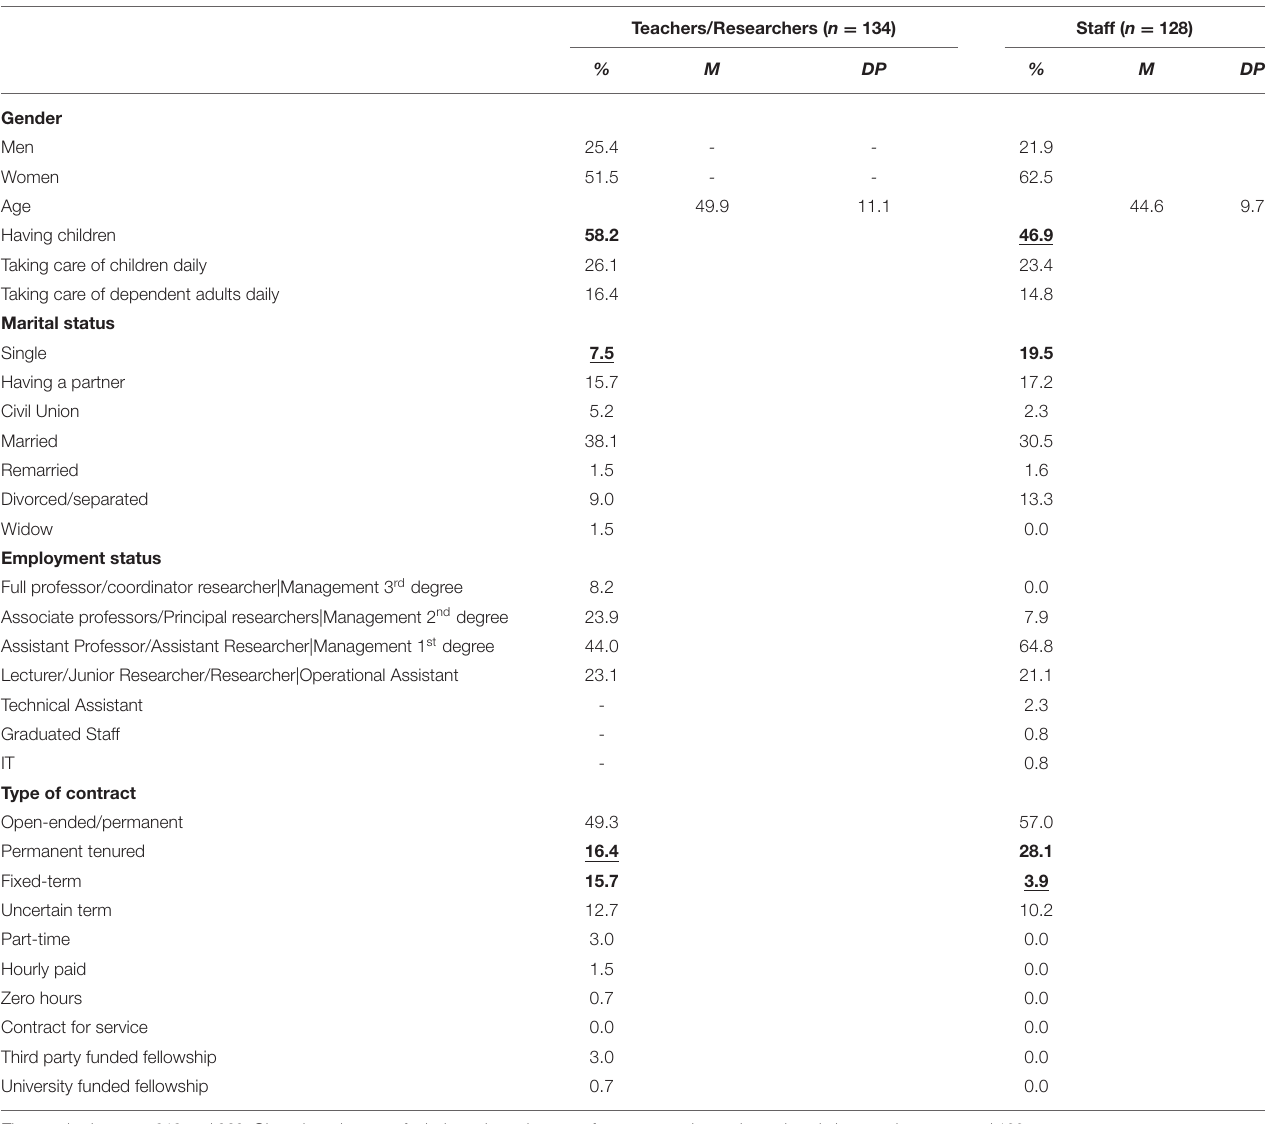
TABLE 1 | Sociodemographic and work characteristics of teachers/researchers and